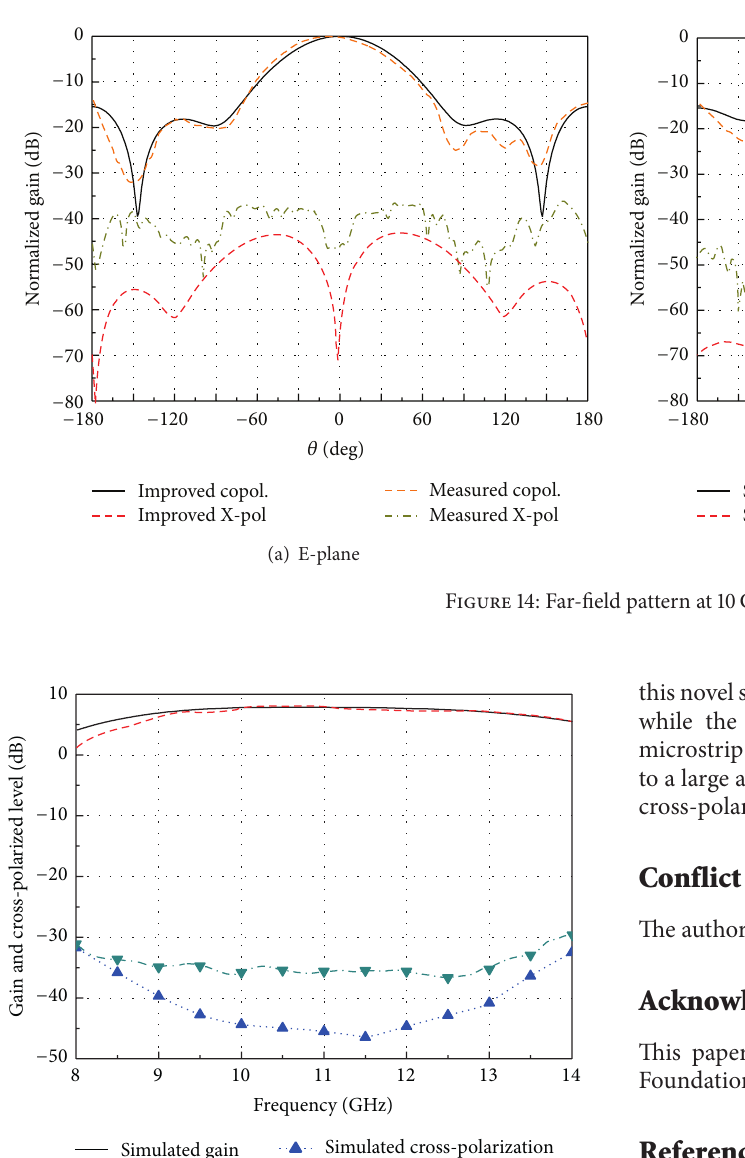
Figure 15: Realized gain and the cross-polarization level versus